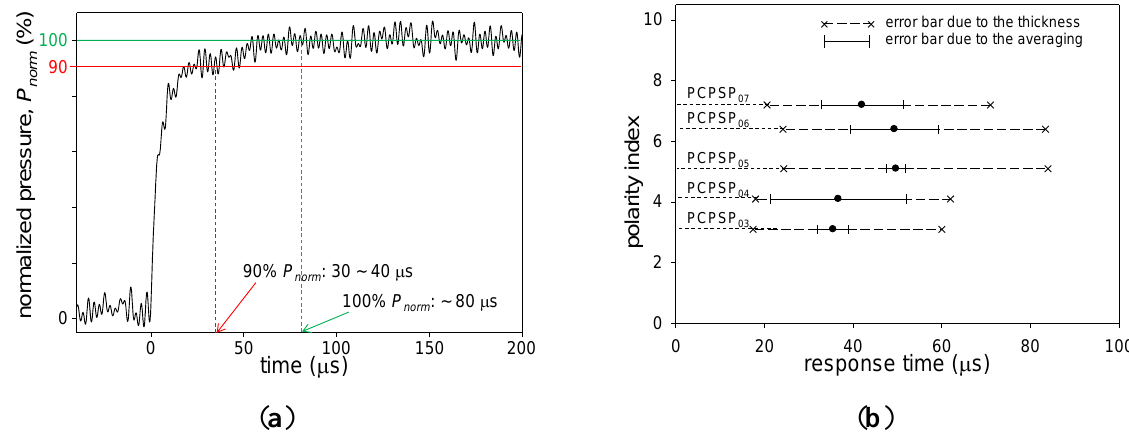
Figure 10. ( a ) Step pressure response of PCPSP time,  (  s), and the polarity